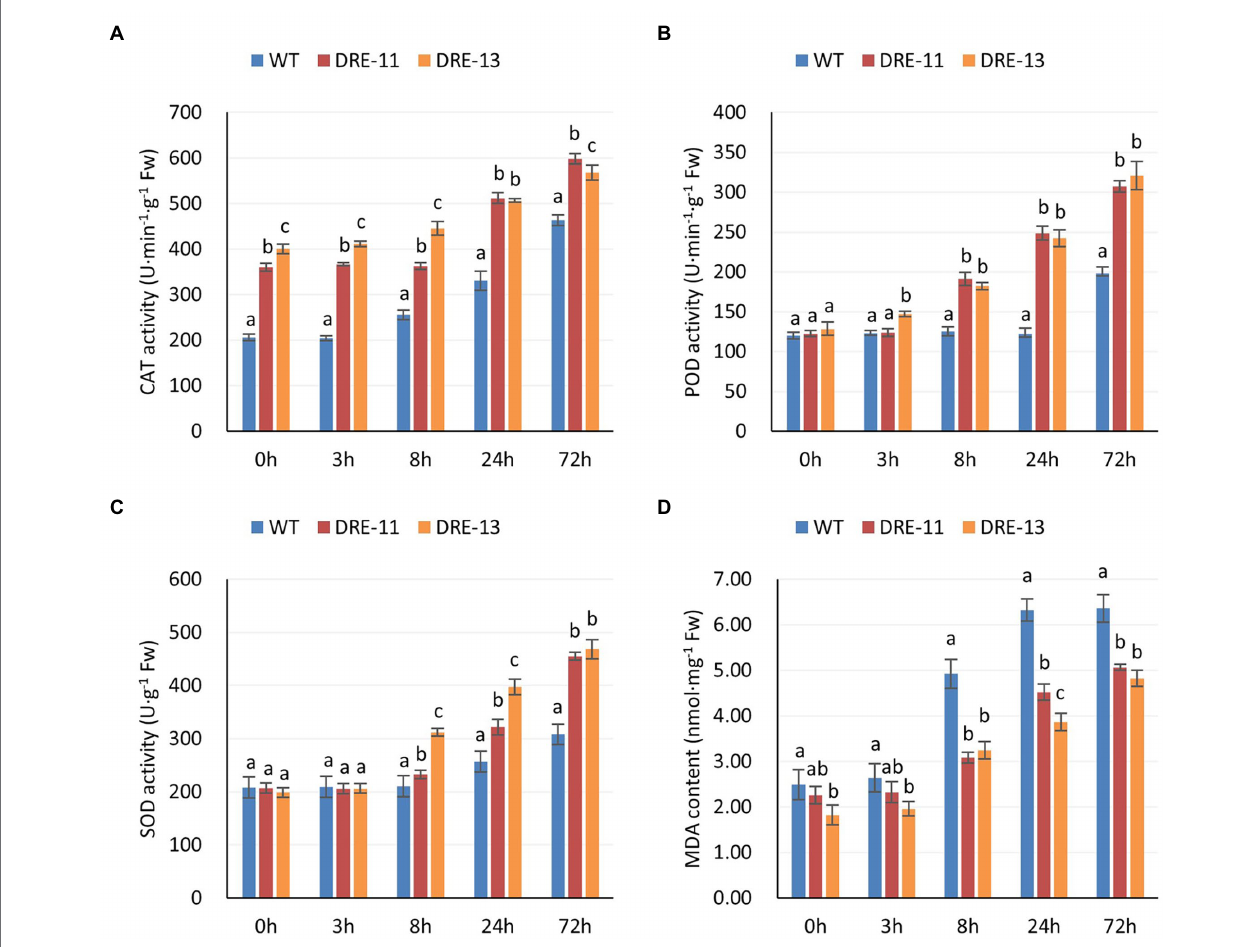
FIGURE 7 | Activities of protective enzymes and MDA content of PaDREB1A transgenic lines and WT plants after different cold stress treatment times. (A) CAT activity. (B) POD activity. (C) SOD activity. (D) MDA content. Means with the same letters are non-significantly different for different transgenic lines and WT